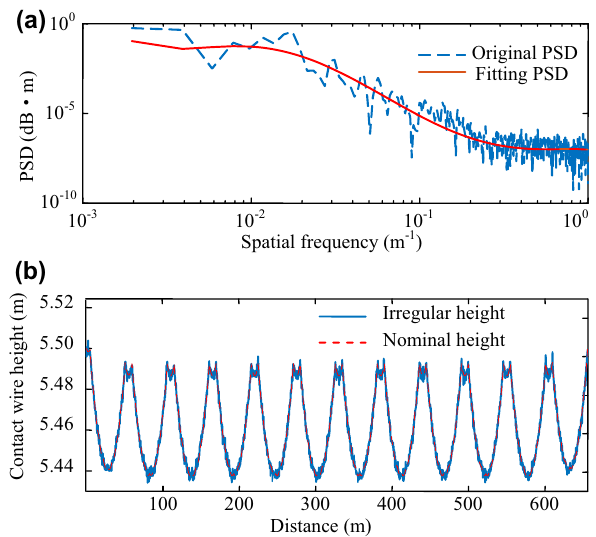
Fig. 13 Contact wire irregularity spectrum ( a ) and the simulation of contact wire irregularity ( b